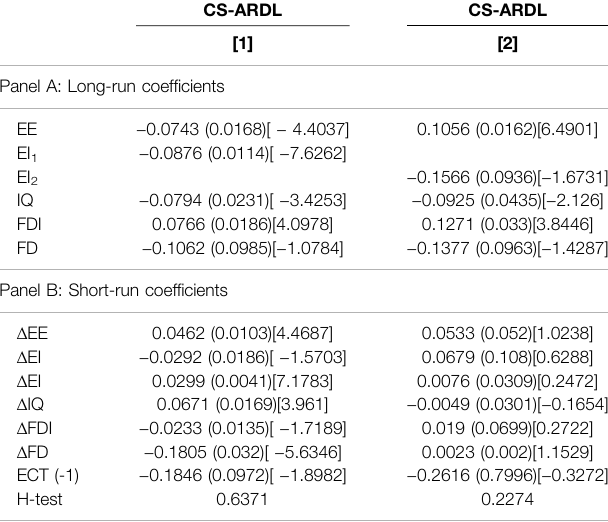
TABLE 7 | Dependent variable ecological footprint as a proxy for environmental sustainability.